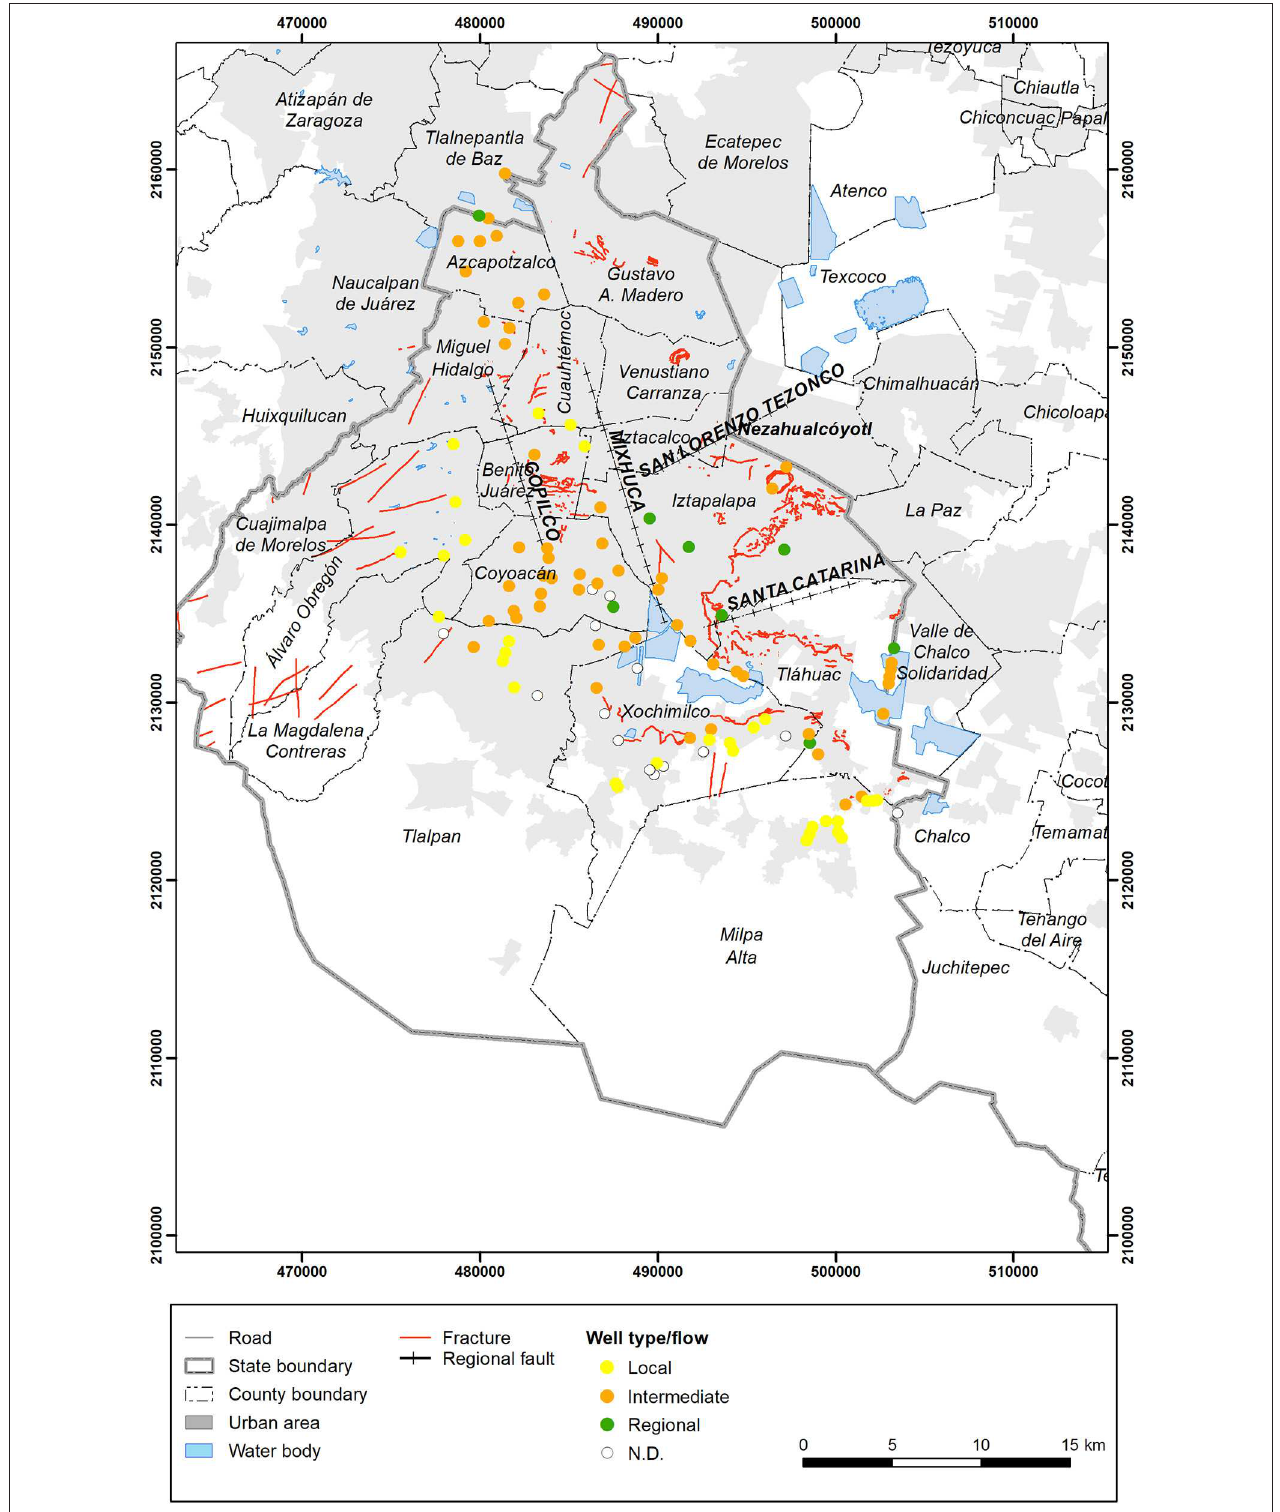
FIGURE 3 | Representation of wells with different flows, local (yellow), intermediate (orange), and regional (green).